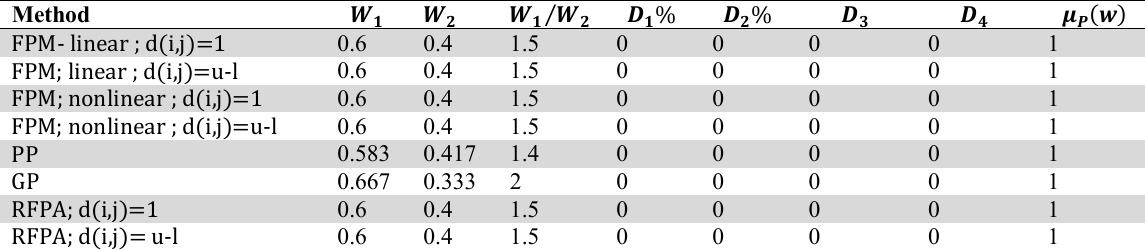
Two-dimensional consistent